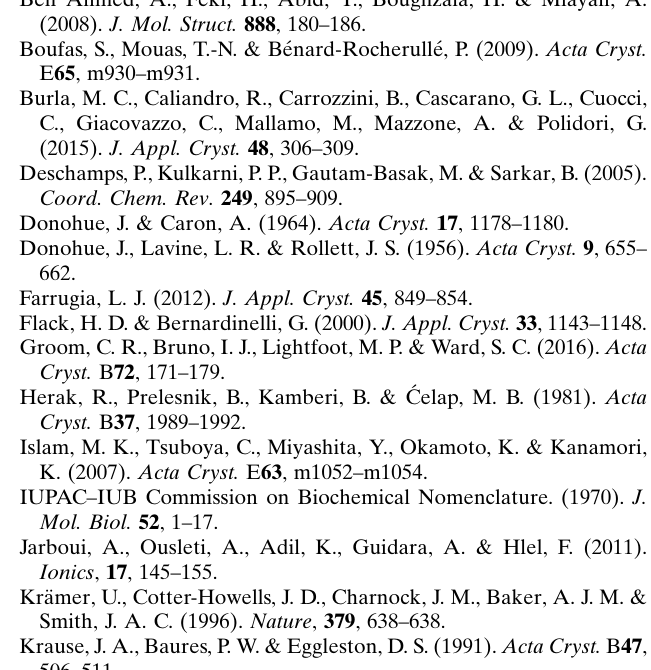
Table 2 Experimental details. Crystal data Chemical